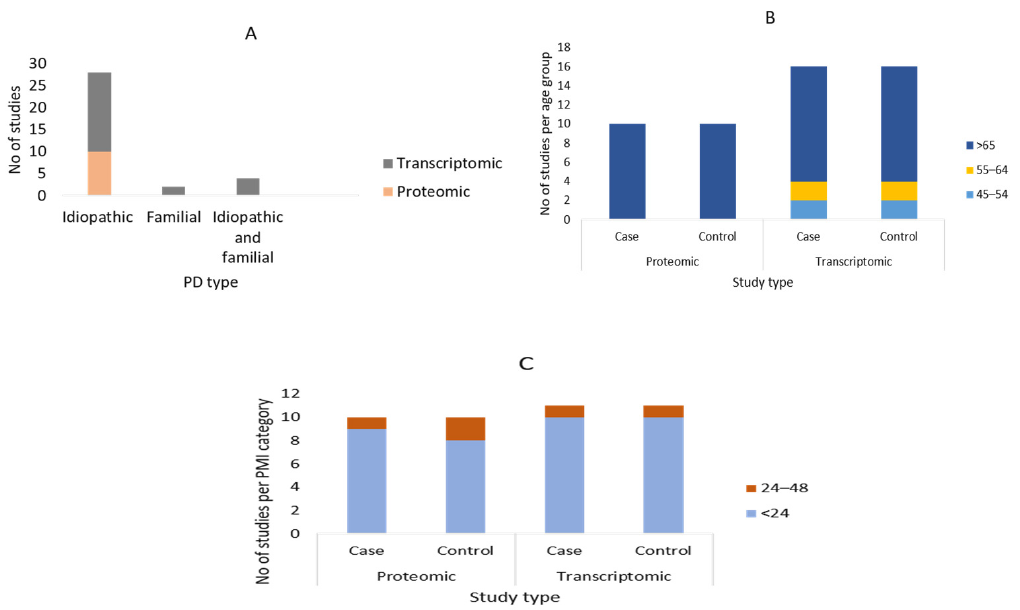
Figure 3. Distribution of patient- and sample-related variables of both proteomic and transcriptomic studies. Distribution of PD type ( A ); age distribution ( B ); PMI distribution of brain tissue-based studies ( C ). Table 1. Patient and sample information from the included proteomic studies.